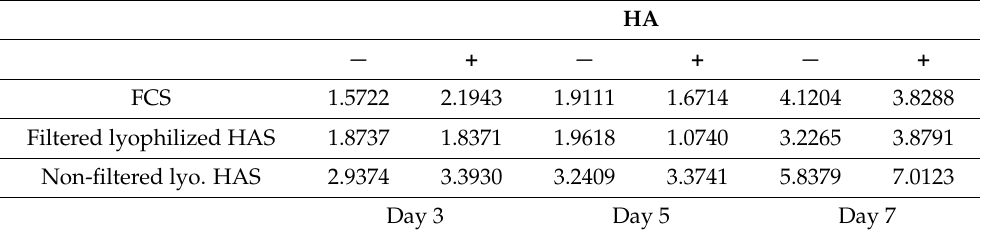
Table 1. Chondrogenic viability after supplementation with hyperacute sera with and without HA.